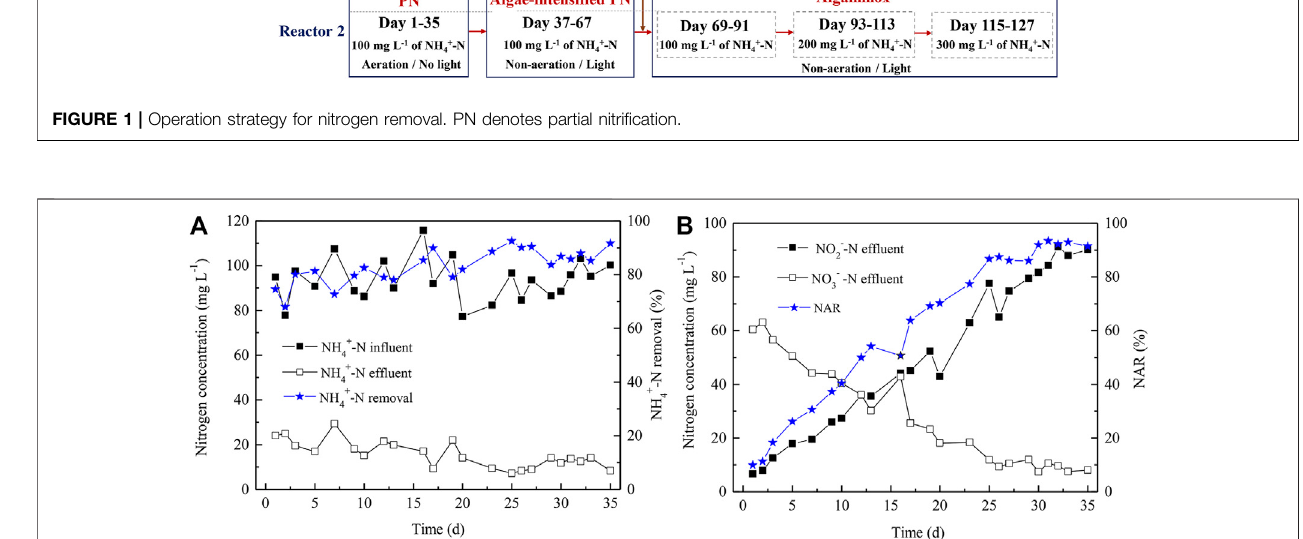
FIGURE 2 | NH 4+ -N removal (A) and NO 2 − -N accumulation (B) in the in fl uent and ef fl uent of the PN reactor. NAR indicates nitrite accumulation rate and was calculated as Con. NO